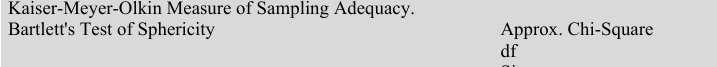
KMO and Bartlett’s Test Kaiser-Meyer-Olkin Measure of Sampling